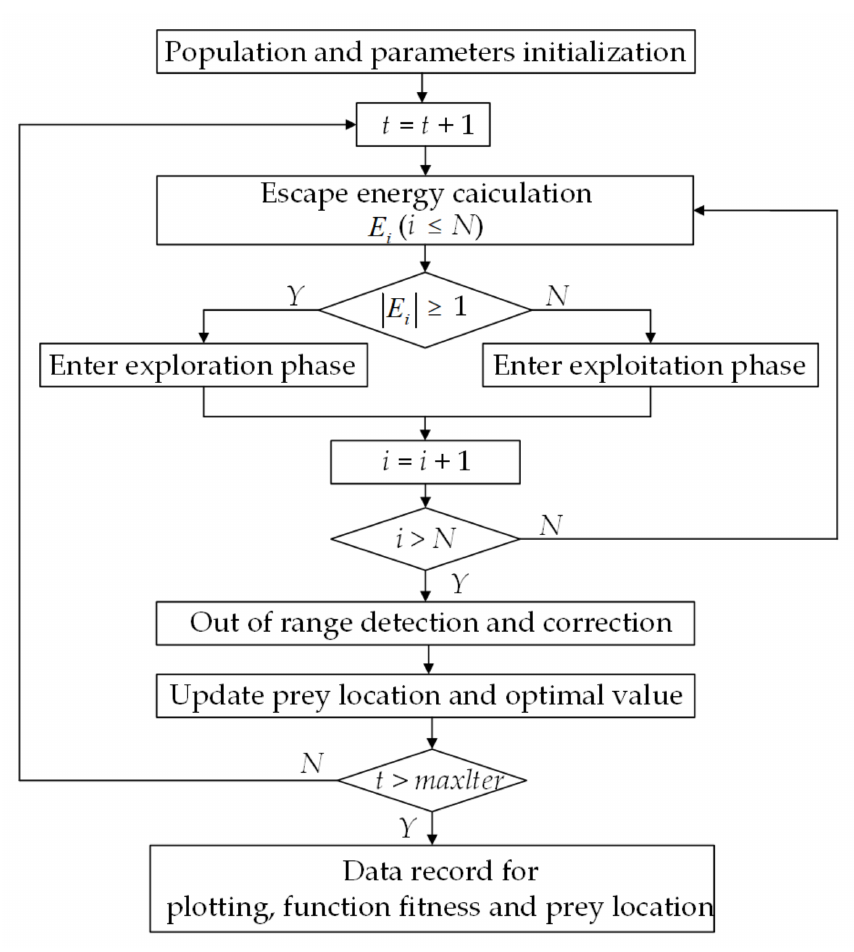
Figure 3. Flow chart of the OMO algorithm. The OMO algorithm has superior performance in most standard test functions. Table 6 shows the details of the six representative standard test functions [61,62]. The population number N and maximum iterations of the OMO optimizer are set to 30 and 300, respectively. The speed control constant of the predator’s Levy flight S H is set to default value 1, and the speed control constant of prey’s standard Brownian motion S R is also set to default value 1, other parameters are consistent with those given in Table 6. Table 6. Details of the six representative standard test